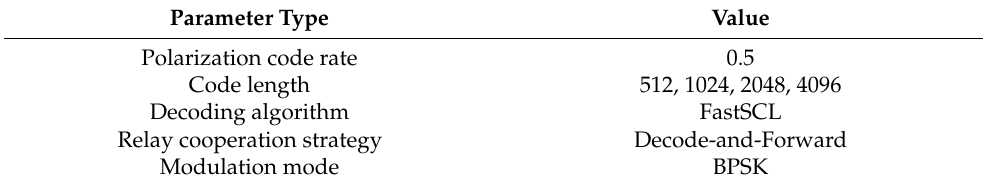
Table 1. Basic parameter settings of polarization coding cooperative FSO communication system